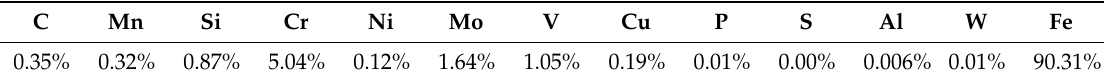
Table 1. Chemical Composition (%) of AISI